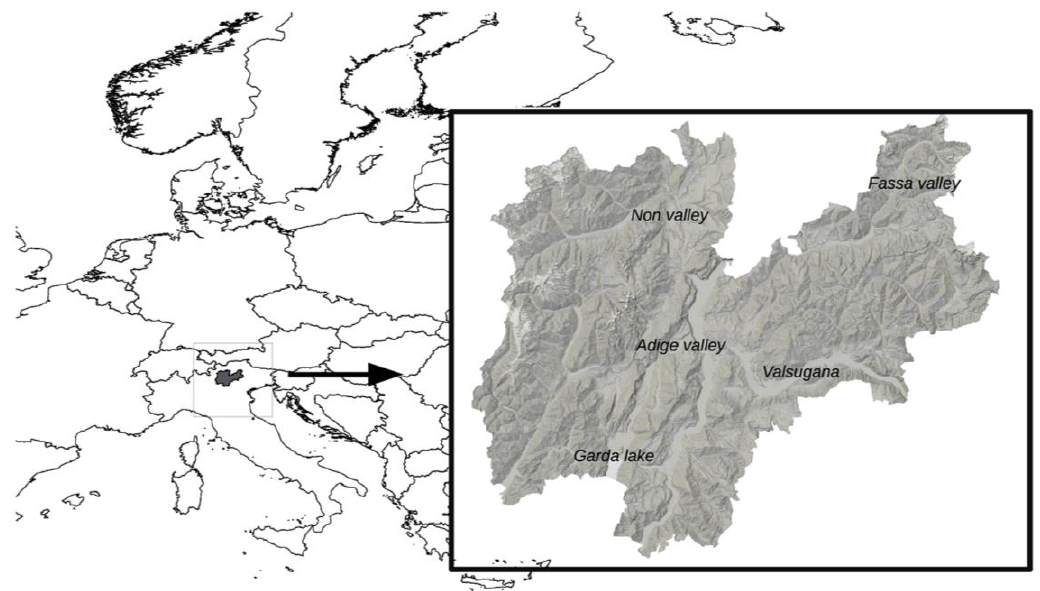
Figure 1. Study area.